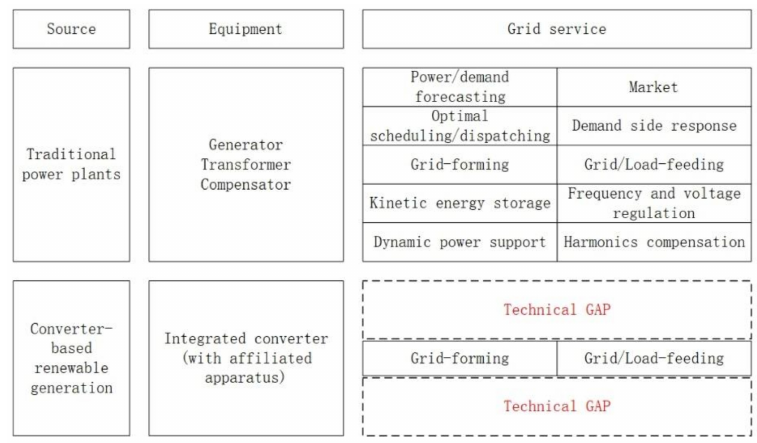
Figure 2. Technical gap of virtual synchronous generator (VSG)-based renewable integration.